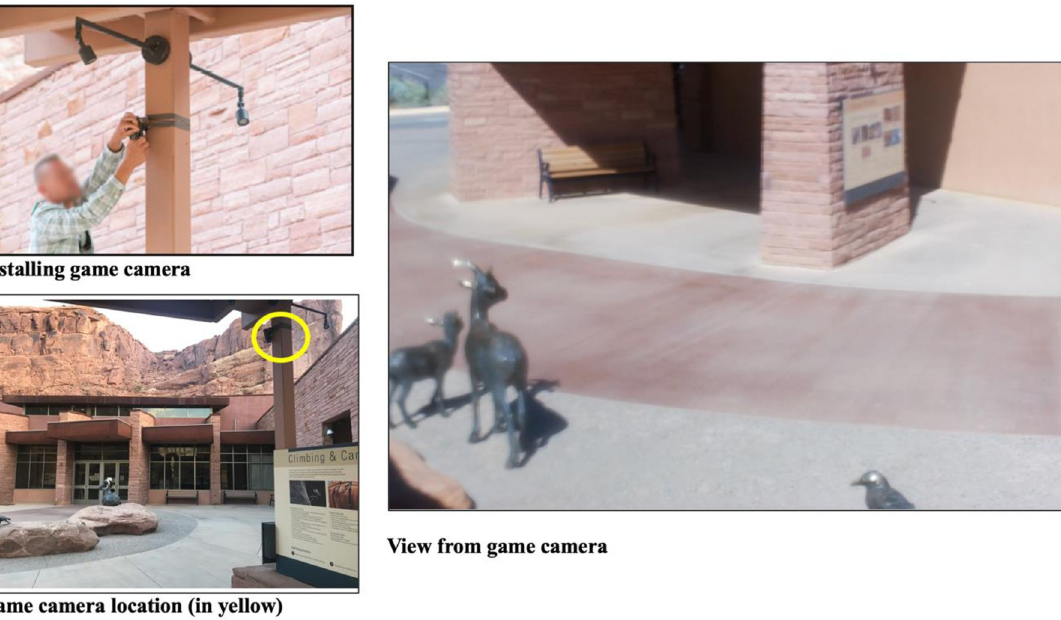
Fig 1. Installation, location, and view from game